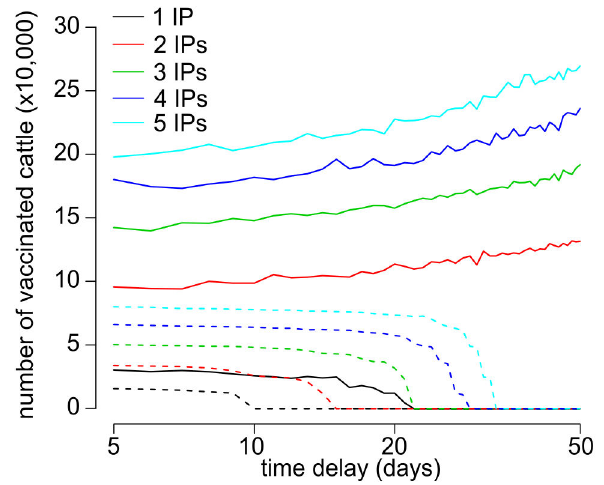
Figure 6. Changes in the number of vaccinated cattle with delays in field implementation. Median number of vaccinated animals (cattle) when controlling a FMD epidemic that were introduced either in Ayrshire (solid line) or Aberdeenshire (dashed line) for increasing time between first detected infected premise (IP) and the field implementation of the vaccination policy and number of infected farms at first